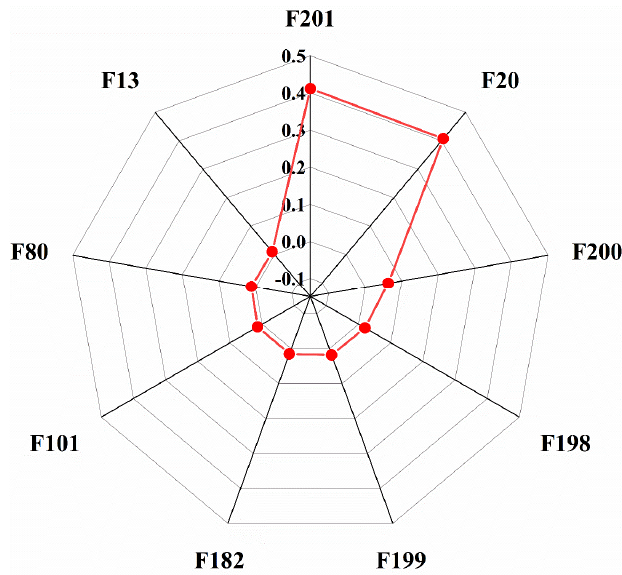
Figure 6. Feature importance ranking.